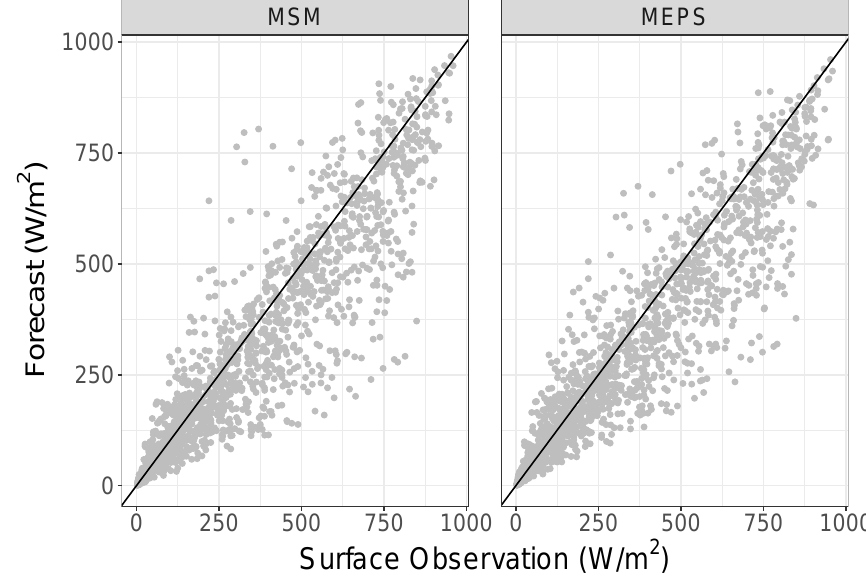
Figure 4. Forecast of average GHI at five sites in the Kanto region by MSM and MEPS. MEPS data is represented by the average of the 21 member